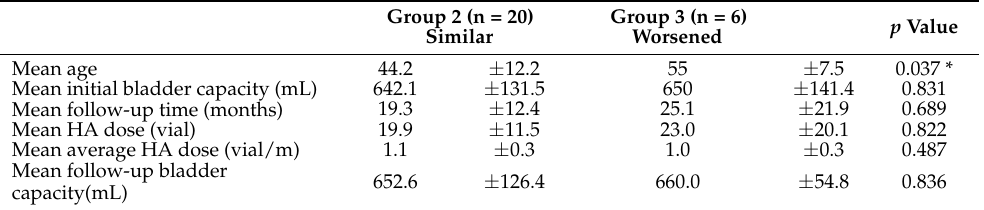
Table 4. The data comparison between the groups with the similar cystoscopic outcomes and worsened